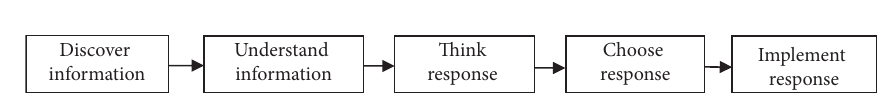
Figure 2: Behavioral cognitive process.